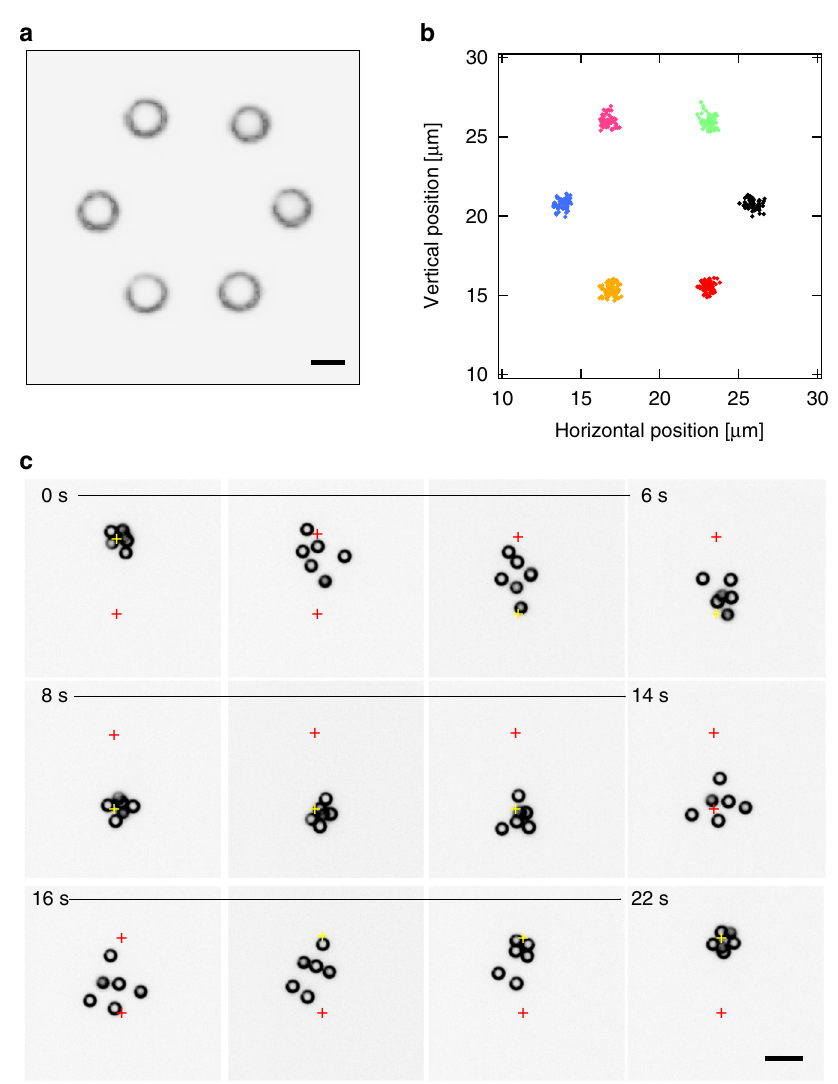
Fig. 2 Controlling multiple self-thermophoretic active particles. a Dark fi eld microscopy snapshot (inverted grayscale) of six active particles ( R = 1.09 μ m) arranged at the nodes of a symmetric hexagon (7.1 μ m edge length) with the help of the particle control procedure described in the text. The incident laser power per particle is P = 0.2 mW. The scale bar has a length of 2 μ m. b Corresponding trajectory points of the particles over a time period of 11 s with Δ t exp = 110 ms exposure time/inverse frame rate. c Dark- fi eld microscopy image series (inverted grayscale) of six active particles driven between two target positions separated by 14.2 μ m. Targets are colored for clarity. The incident heating power per particle is P = 0.2 mW and the time resolution of the experiment is Δ t exp = 80 ms. The scale bar has a length of 7 μ